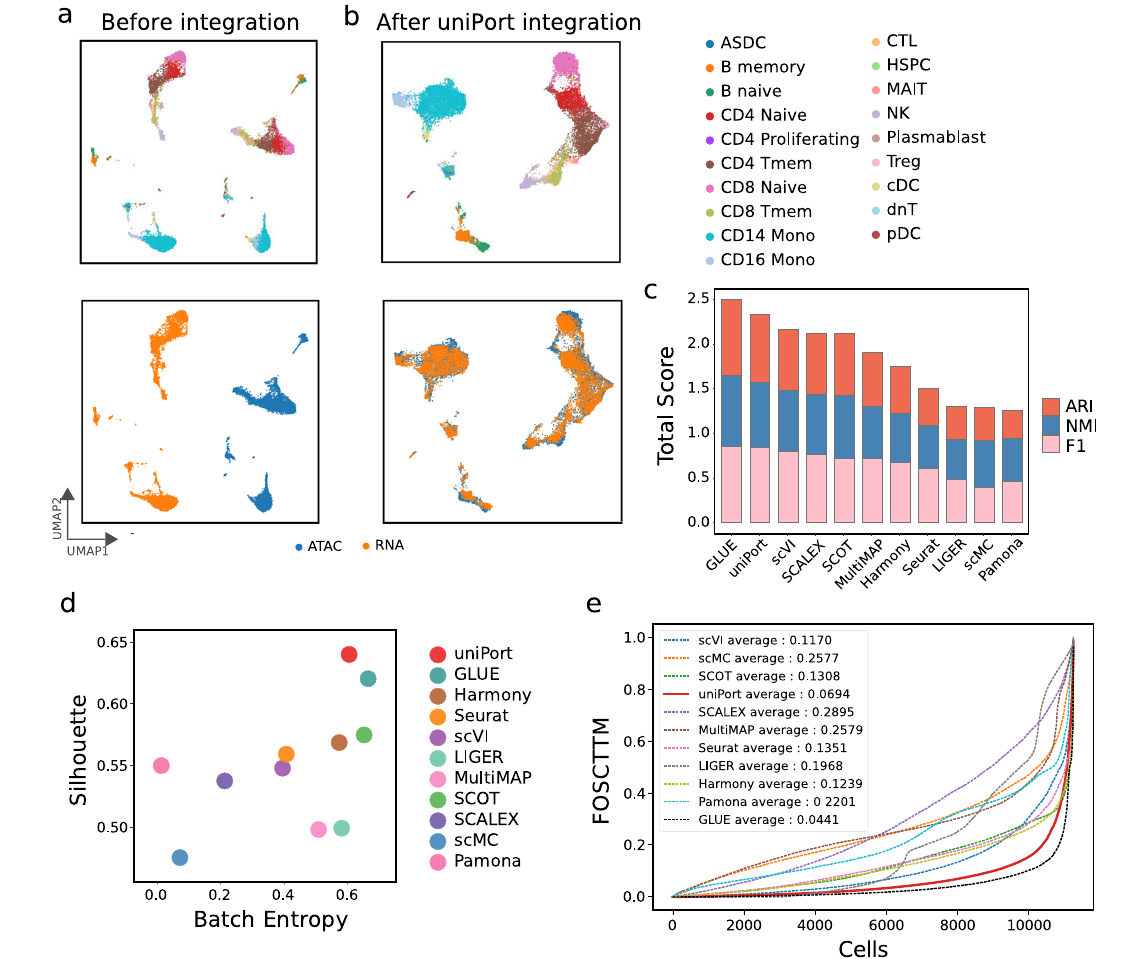
Fig.2|uniPortintegratespairedscATACandscRNAofthePBMCdatafrom10× Genomics.a UMAPvisualizationofPBMCdatabeforeintegrationcoloredbyomics and cellannotations. b UMAP visualizationofPBMC data afteruniPort integration.